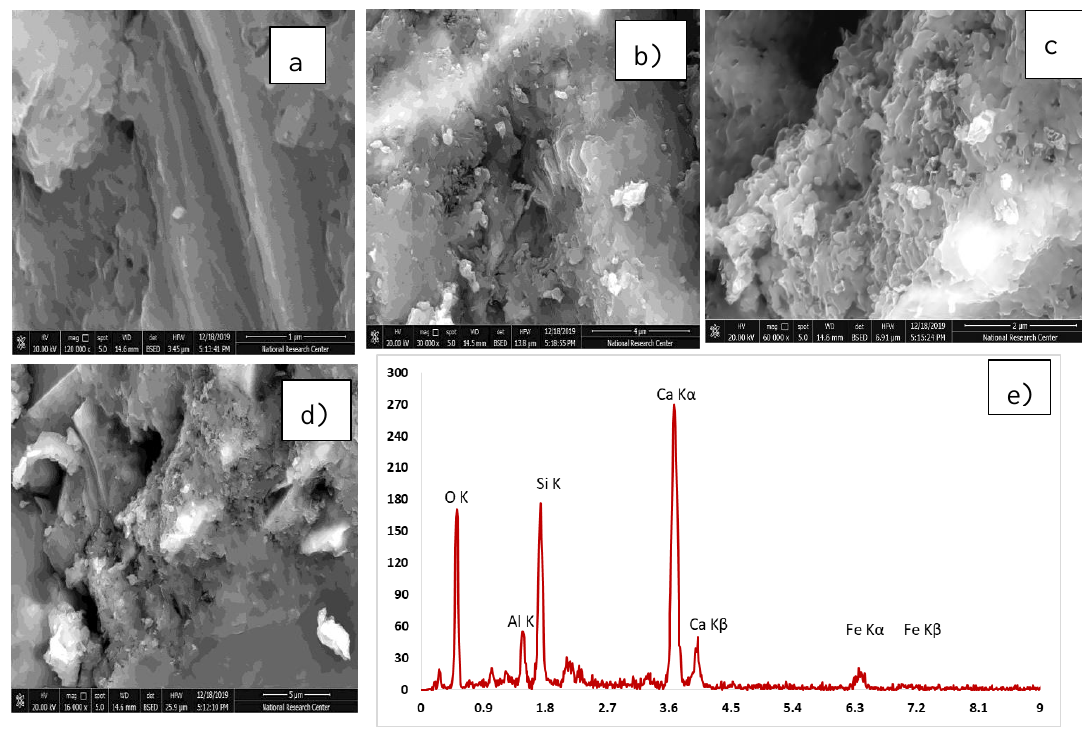
Figure 15. SEM and ( a – d ) SEM images at different magnification factor and ( e ) EDX for the UHPC mix incorporating 1% nano-metakaolin.